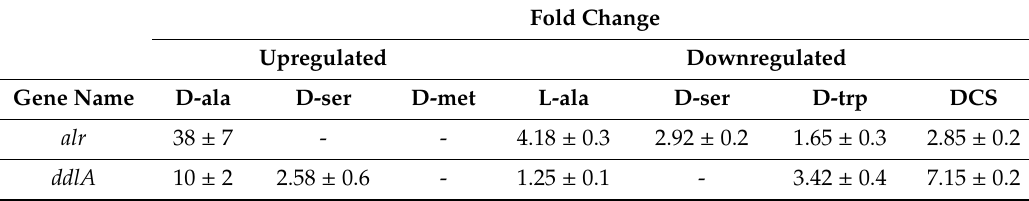
Table 1. Analysis of the relative expression of alr and ddlA genes in the present of LAs and DAs by real-time PCR (RT-PCR). The relative expression of alr and ddl genes after incubation of C. jejuni 11168-O cells with 25 mM of LAs and DAs for 2 h.